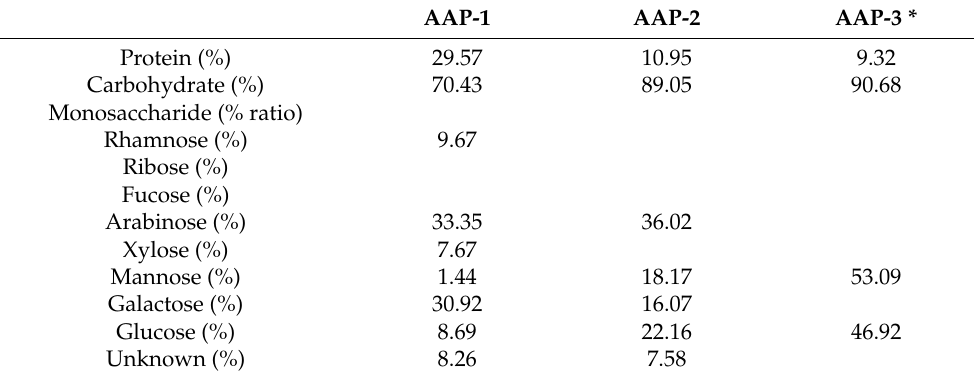
Figure 2. Gel filtration chromatograms of polysaccharide fractions from A. annua . Table 1. Sugar composition of polysaccharide fractions isolated from A. annua